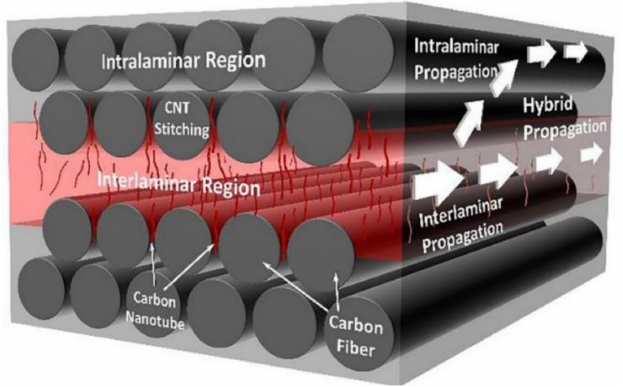
Figure 15. Illustration of crack propagation route in RFI fabricated nanocomposite [136]. Reprinted with permission from